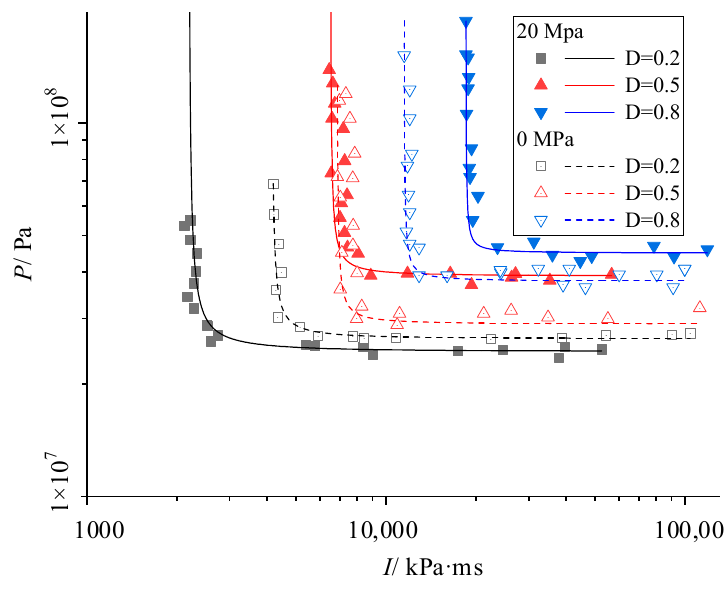
Figure 9. Influence of geostress on P-I curves.